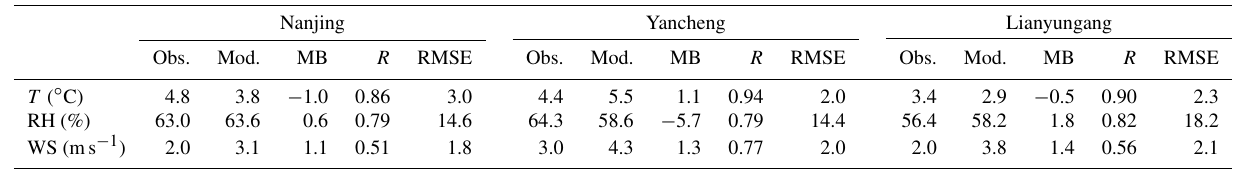
Table 2. Statistics between observed (Obs.) and modeled (Mod.) meteorology. Nanjing Obs. Mod. MB R RMSE Obs. Mod. MB RMSE